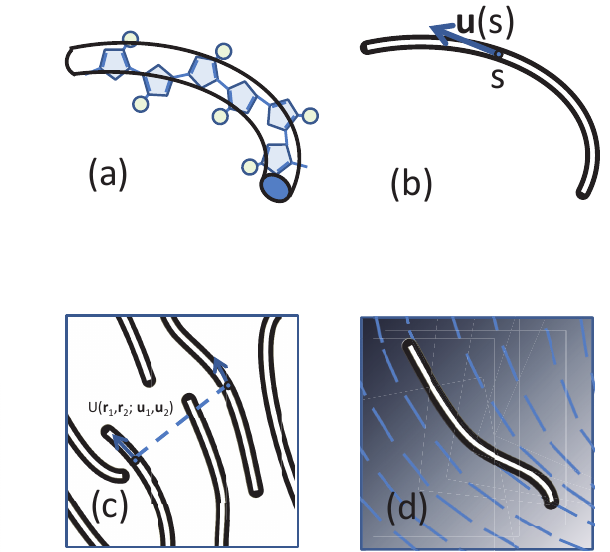
Figure 1. Sketches of ( a ) approximating a real polymer by a backbone wormlike chain; ( b ) the definition of the tangent direction of a polymer segment; ( c ) compressible polymers that have a direction ordering and ( d ) the concept of self-consistent field theory (SCFT), which treats the monomer-monomer interaction by a directionally-dependent background field, illustrated by blue